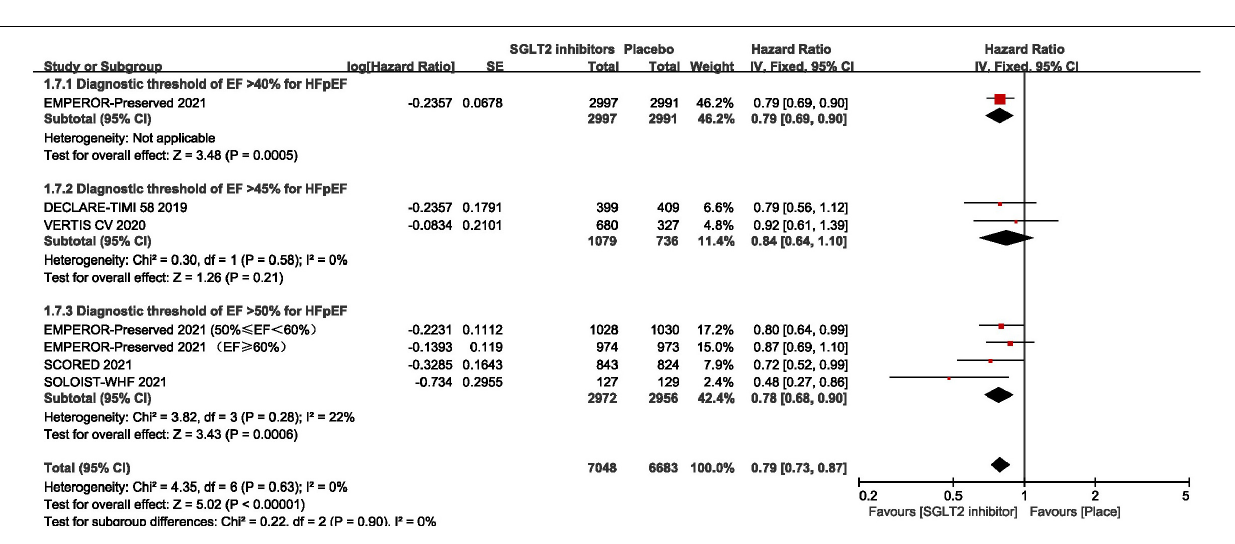
FIGURE 4 | Forest plot displaying the results of subgroup analysis by various thresholds of ejection fraction used in the diagnosis of HFpEF.